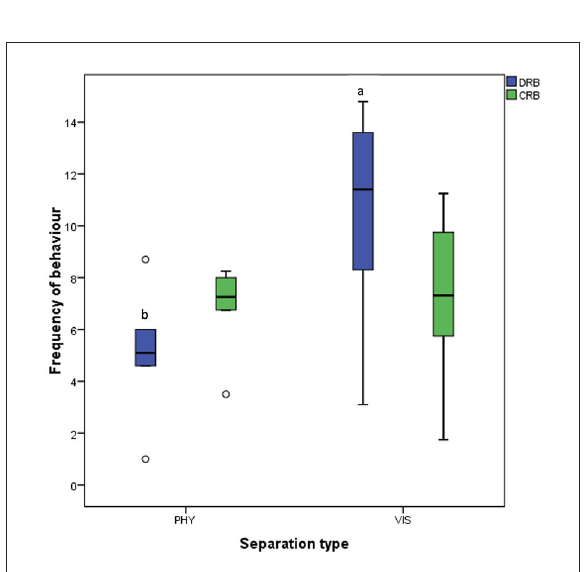
FIGURE8 Frequency of discomfort-related (DRB) and comfort-related (CRB) behaviors of the mother hens when subjected to 10-minute physical (PHY) or visual (VIS) separation from their chicks. ab Means differ at P < 0.05 for discomfort-related